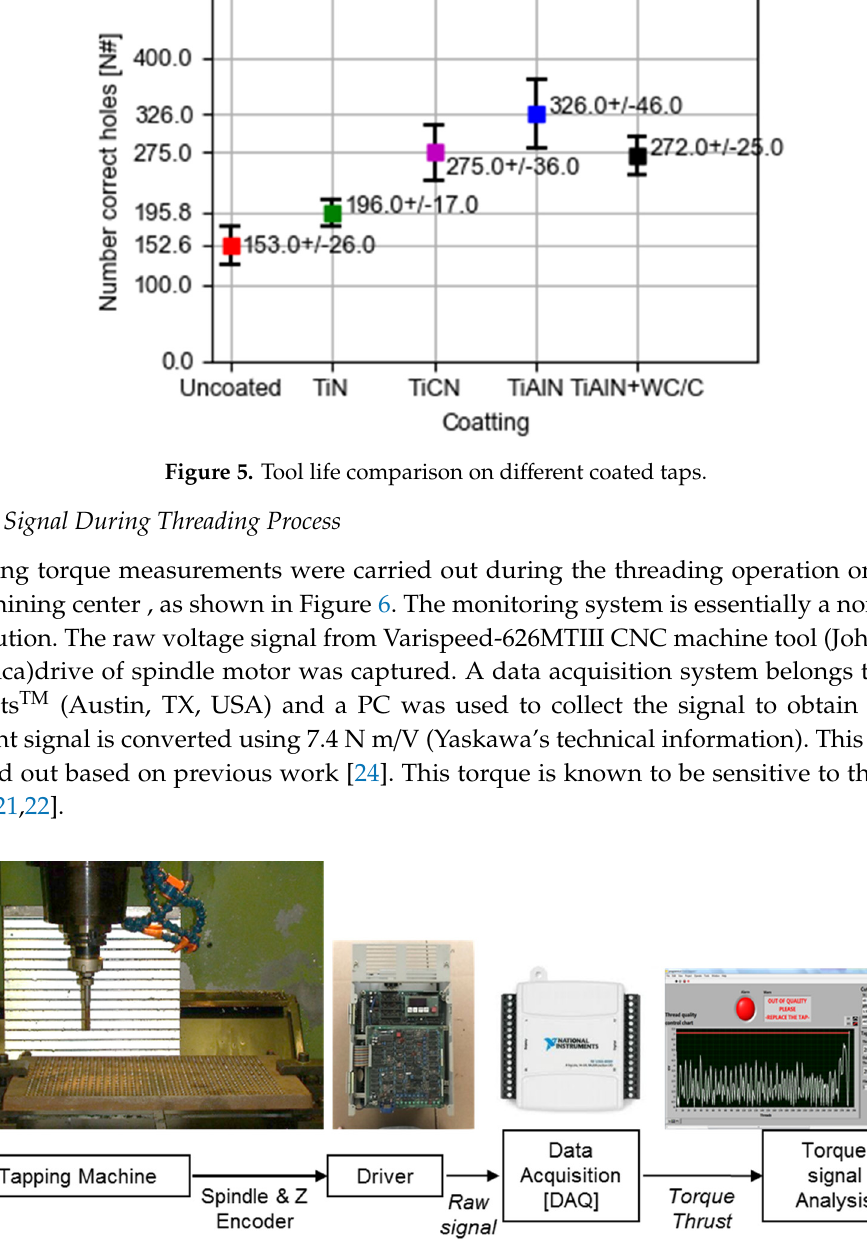
Figure 6. Set-up for torque monitoring.